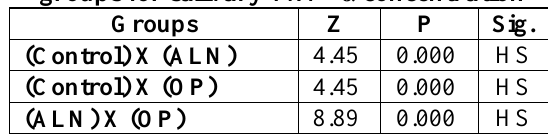
Table 6: Multiple comparisons among groups for salivary TNF- α concentration